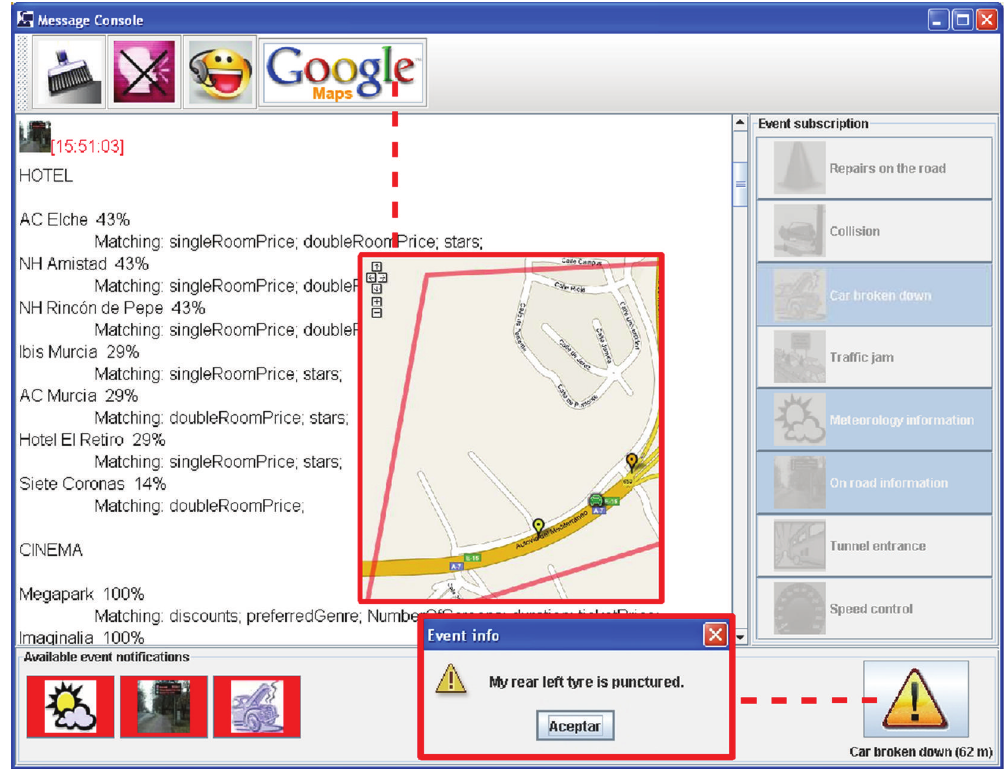
Figure 5: On-board software with tra ffi c and POI notification services.